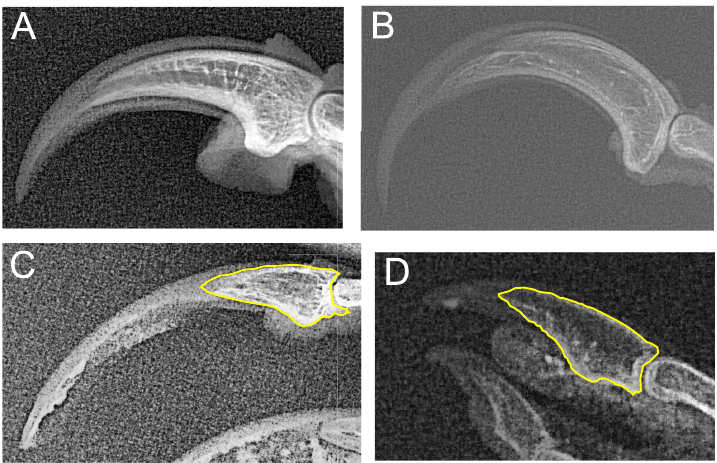
Fig 5. Radiographs of pedal digit III claws exhibiting significant morphological disparity. Ungual bones outlined in yellow have inner curvatures measured at zero. (A) Right claw of kakapo ( Strigops habroptila ). Specimen 1882.41.3, National Museum of Scotland (B) Left claw of ivory-billed woodpecker ( Campephilus principalis ). Unregistered skin, National Museum of Scotland. (C) Right claw of willow ptarmigan ( Lagopus lagopus ). Skin specimen 1984.2.197, Liverpool World Museum. (D) Left claw of gull ( Larus canus ). Skin specimen 1384, National Museum of Scotland.